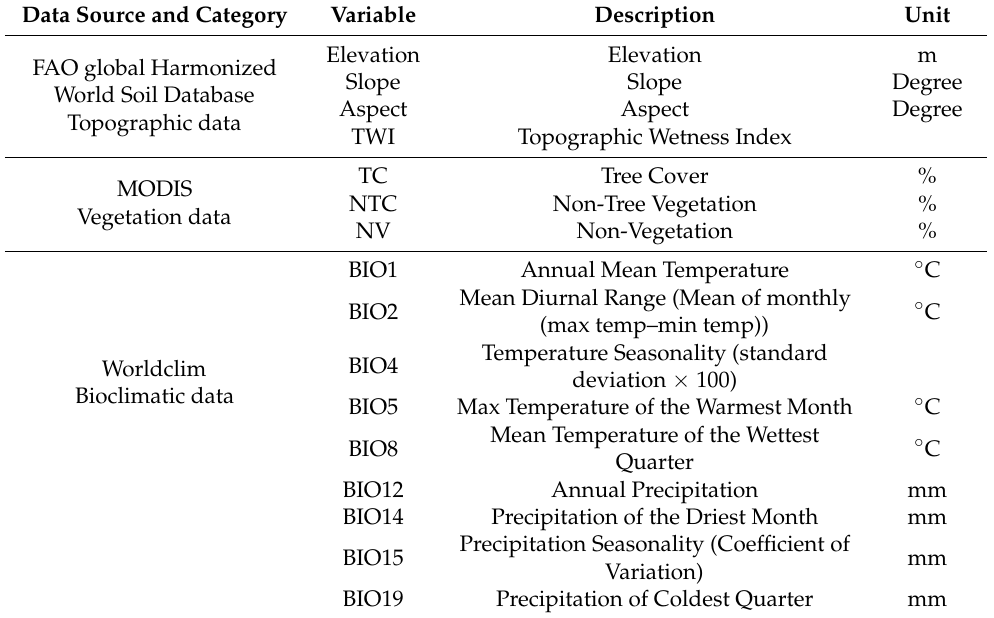
Table 1. Selected environmental parameters used to run the MaxEnt model: source, abbreviations, and